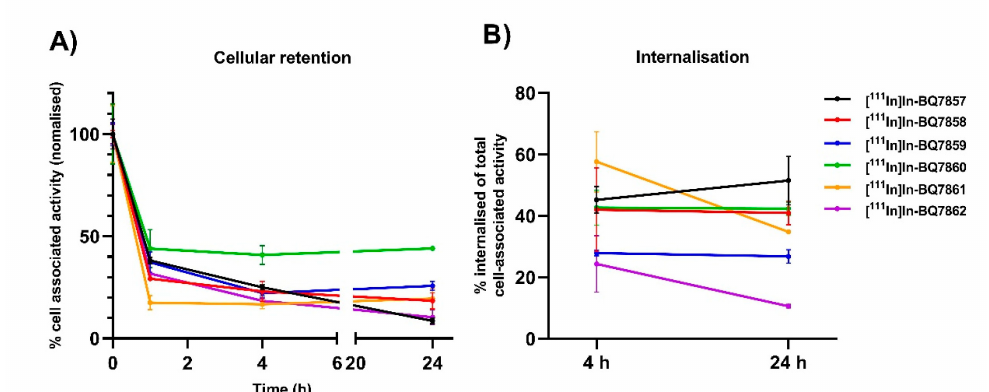
Figure 6. In vitro binding specificity of compounds [ 111 In]In-BQ7857-62 (SET 2) in PSMA-expressing PC3-pip cells. To block PSMA, 500 nM/well of non-labelled PSMA-11 or a non-labelled variant of the compound of interest (self-blocked) were used. Statistical analysis was done using an unpaired, two-tailed t -test.